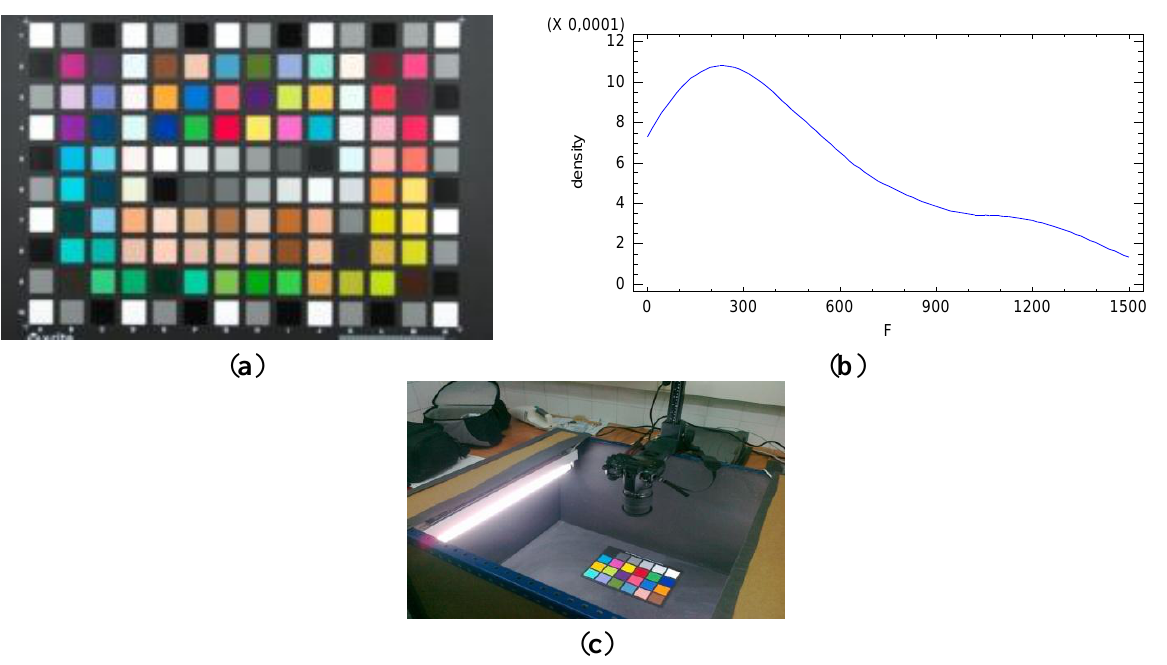
Figure 1. ( a ) Colorcheker chart formed by 140 regions with different reflectance characteristics; ( b ) Probability function of the radiometric values F ; ( c ) Experimental light